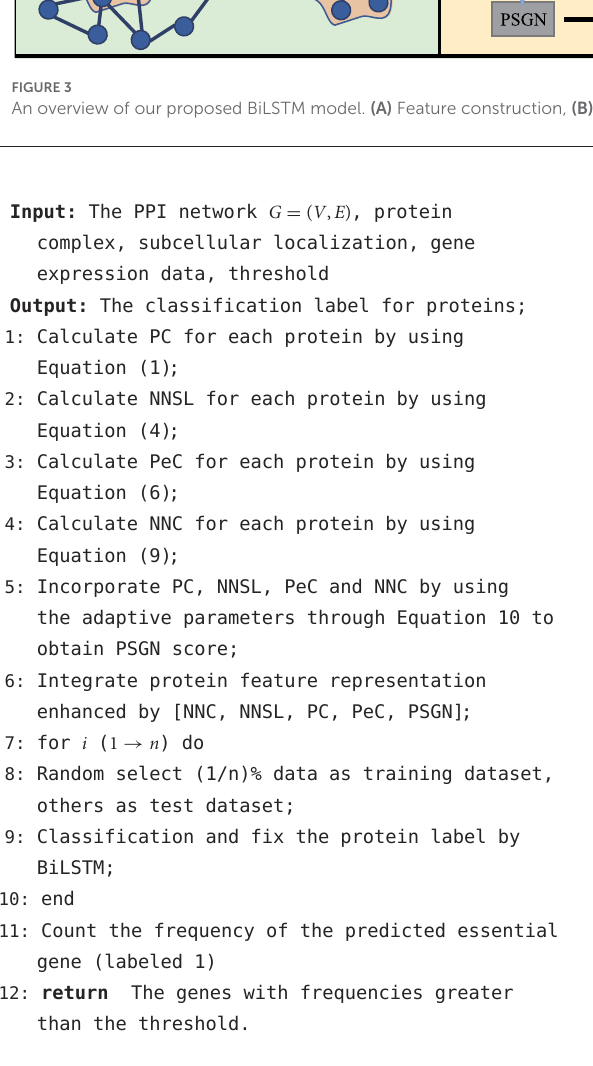
Algorithm 1. BiLSTM for prediction of potential pan-cancer related genes.